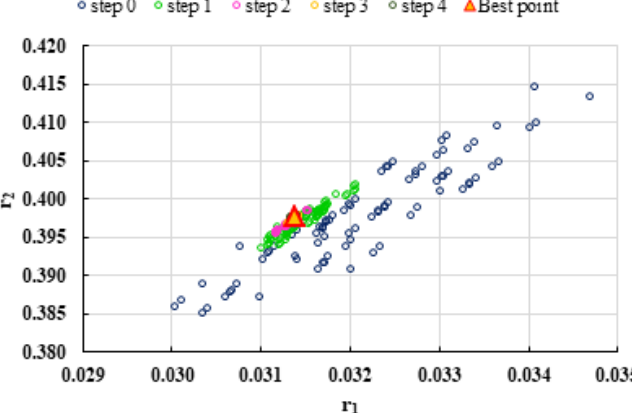
Figure 4. Distribution of P cen (r 1 , r 2 ) points for each step of searching for the k-NN method for the conditions imposed by MC1.